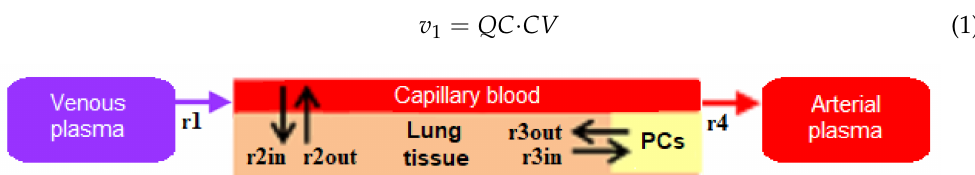
Figure 2. Reactions of nanoparticle transport between the lung subcompartments. (Adapted with permission from https://pubs.acs.org/doi/10.1021/acsnano.9b08142 accessed on 1 April 2022. Copy- right (2020) American Chemical Society. Further permissions related to the material excerpted should be directed to the American Chemical